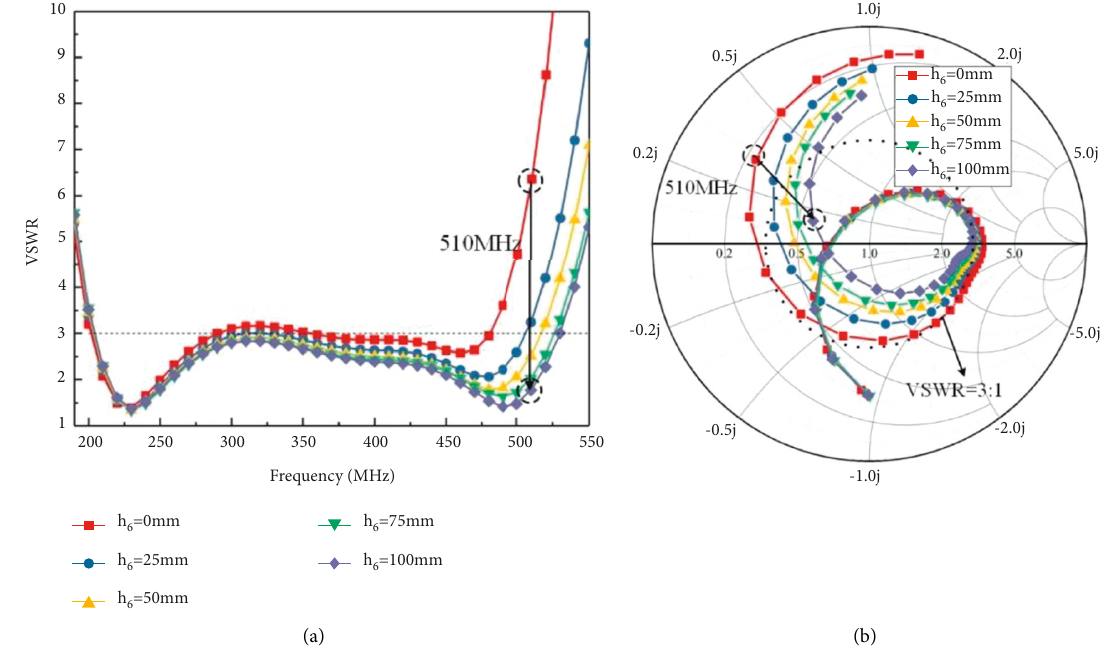
Figure 14: (a) VSWR curves and (b) Smith charts with different values of h